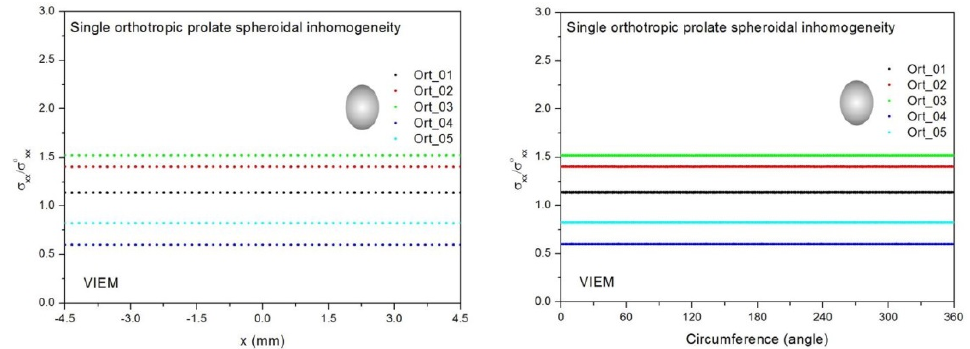
Figure 15. VIEM results for the normalized tensile stress component ( σ xx / σ oxx ) along ( left ) the x–axis inside and ( right ) the circumferential direction of the orthotropic prolate spheroidal inclusions (Ort_01, Ort_02, Ort_03, Ort_04 and Ort_05) with a/b = c/b = 0.75 (b = 6 mm) under uniform remote tensile loading.